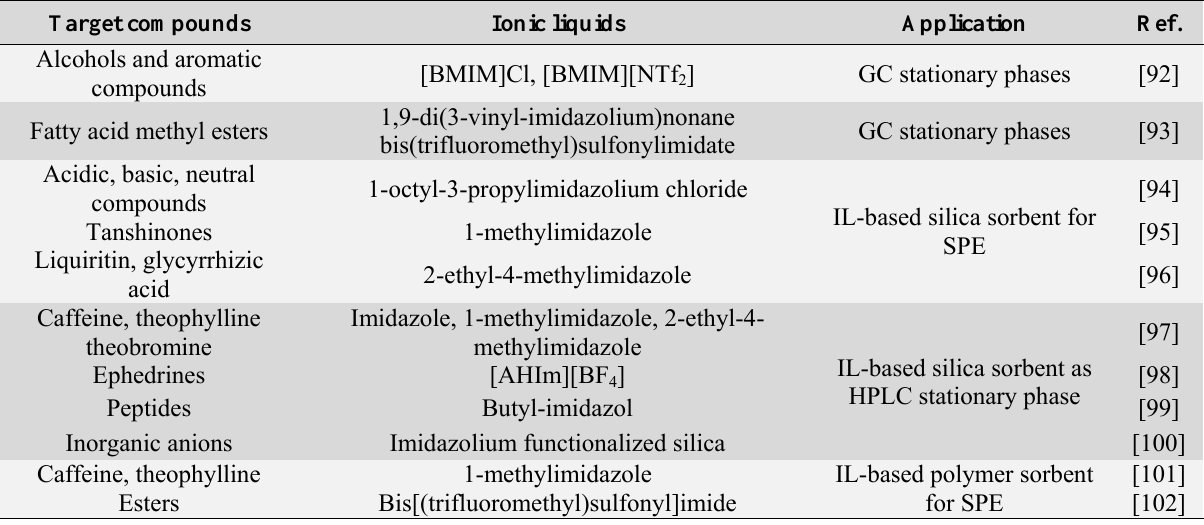
Table 5. Application of ionic liquid as surface-bonded stationary